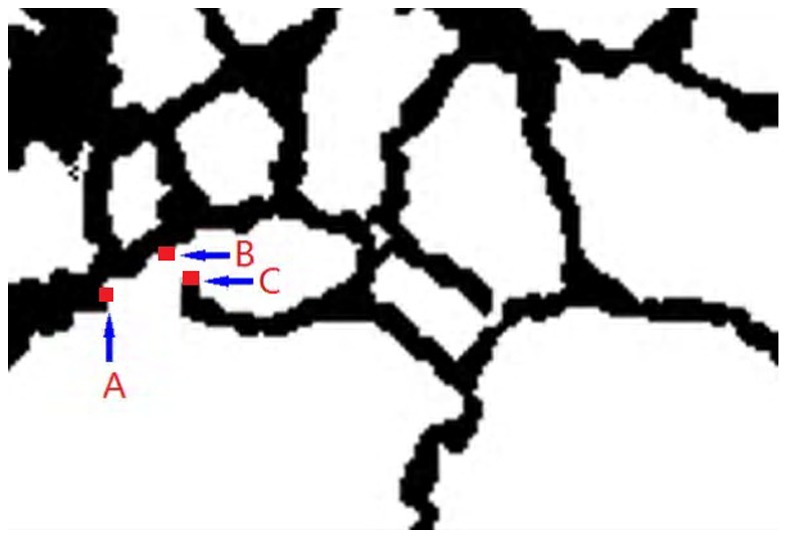
A curve with a gap between A and B rather than A and C which is nearer than B.However connecting A and C is incorrect.